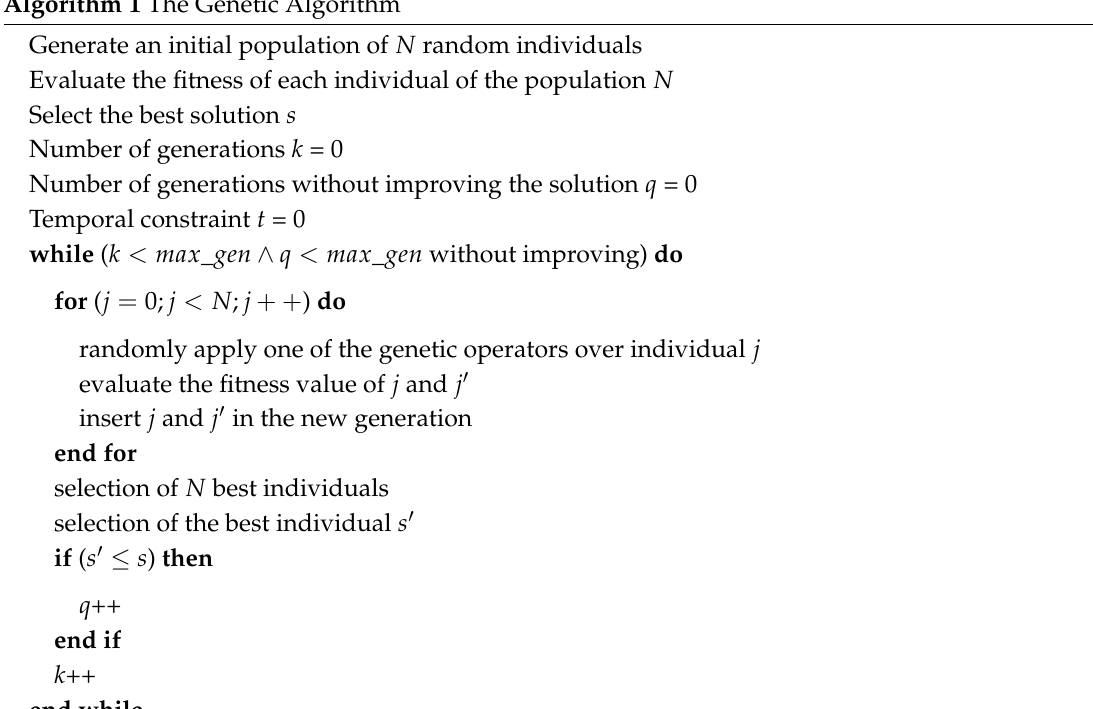
Algorithm 1 The Genetic